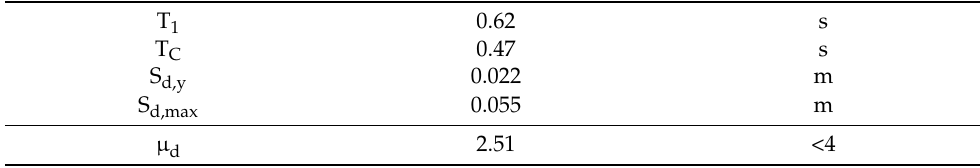
Table 18. Ductility request for case study 6.